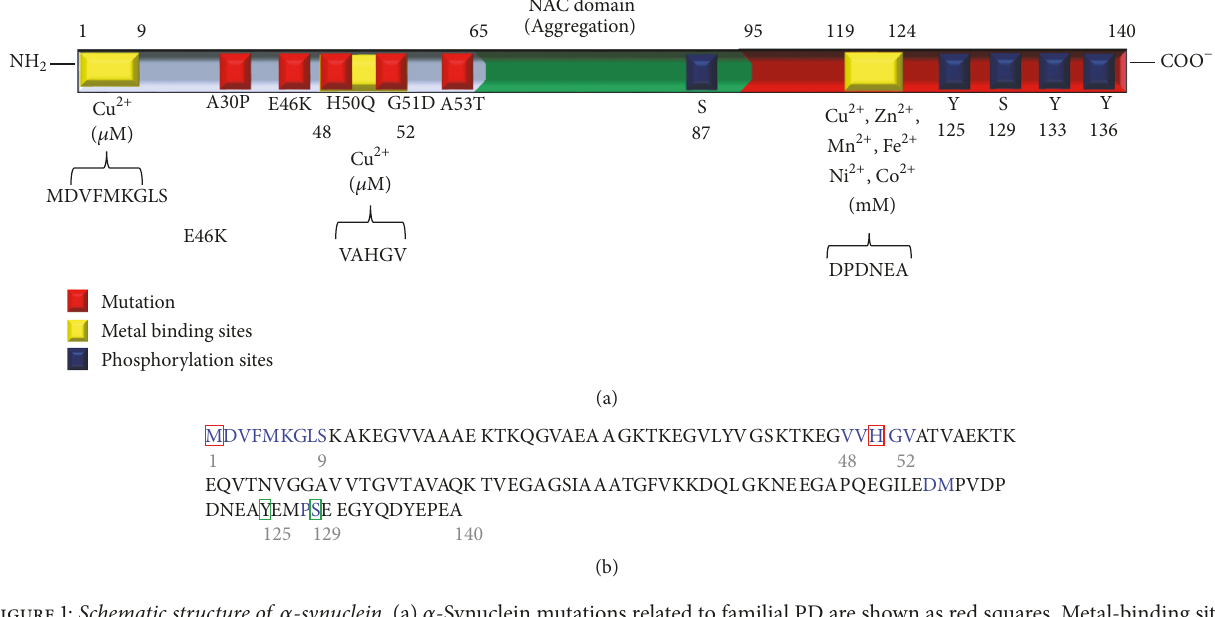
Figure 1: Schematic structure of 𝛼 -synuclein . (a) 𝛼 -Synuclein mutations related to familial PD are shown as red squares. Metal-binding sites are depicted as yellow squares. Seine (S) and threonine (Y) amino acid residues targeted by phosphorylation are indicated as blue squares. (b) Amino acid composition of 𝛼 -synuclein. Residues in blue represent copper-binding sites. Red squares indicate methionine 1 and histidine 50, which are independent anchoring sites for copper binding. Green squares show phosphorylation sites (Y125 and S129) related to an increased copper-binding